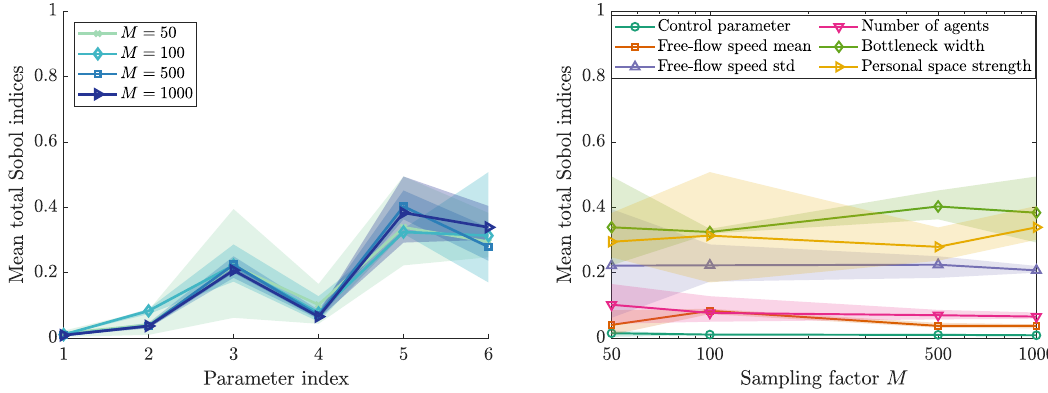
Figure A4. Total order Sobol’ indices for the new range of the personal space strength parameter. The parameter index is mapped as follows: 1—control parameter, 2—free-flow speed mean, 3—free-flow speed standard deviation, 4—number of agents, 5—bottleneck width, 6—personal space